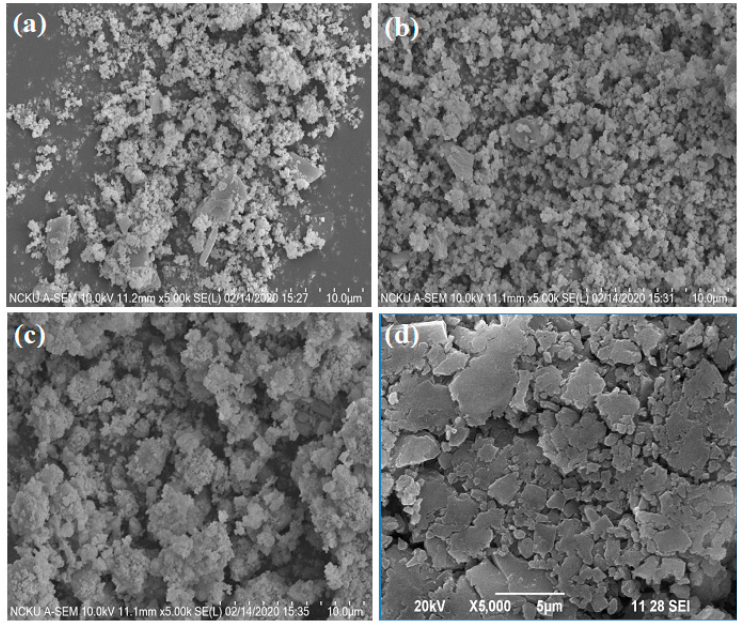
Figure 2. SEM images of the hybrid materials of ( a ) CPA, ( b ) CPB, ( c ) CATCP, and ( d ) CBTCP.